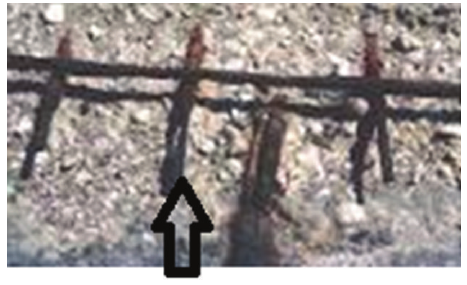
Figure 1: Deterioration resulting from corrosion.